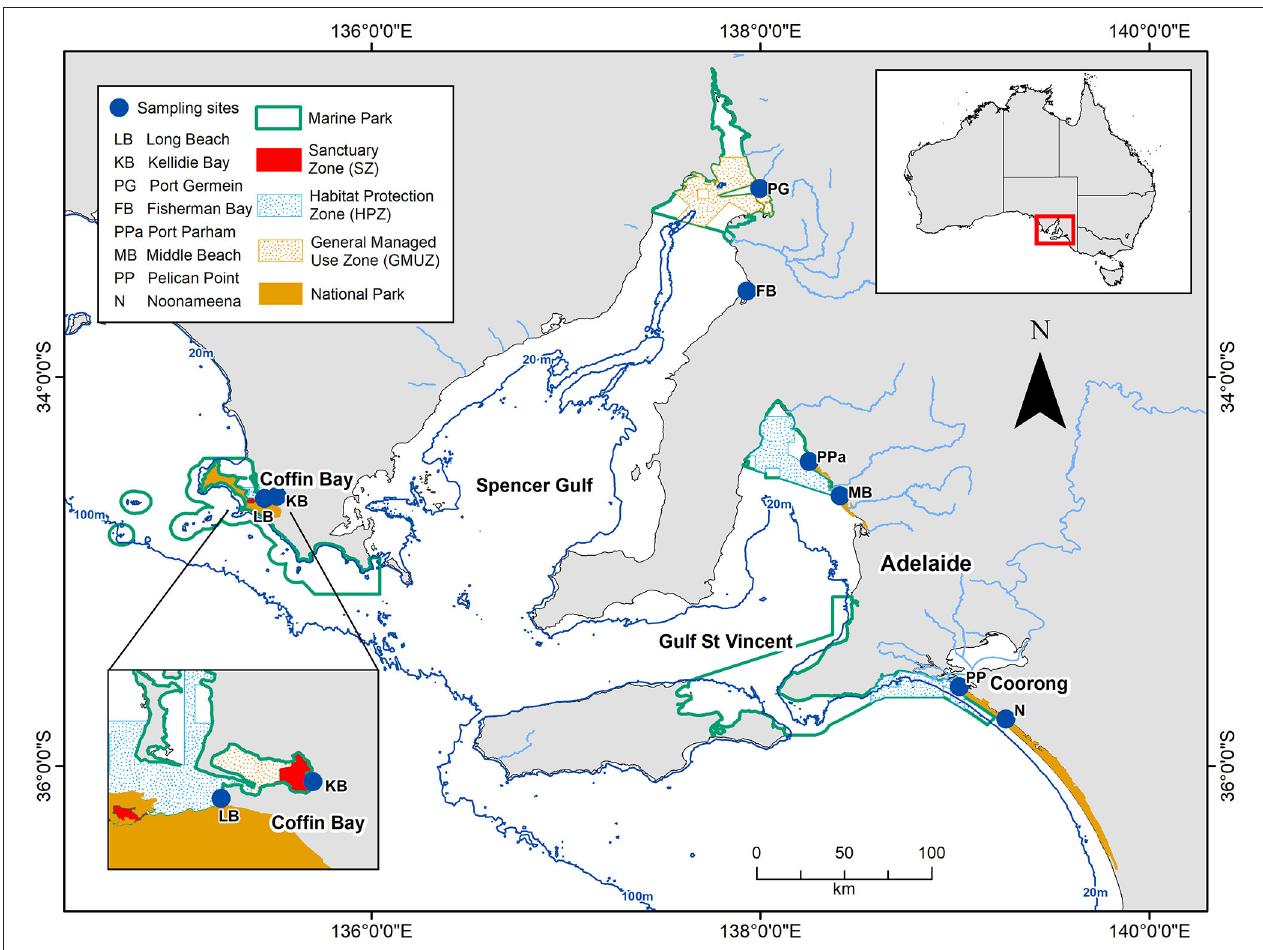
FIGURE 1 | Map of the study area showing the eight sites across South Australia from where benthic macrofauna samples were collected. The dark blue lines indicate depths at 20 and 100m, and the light blue lines indicate the rivers.